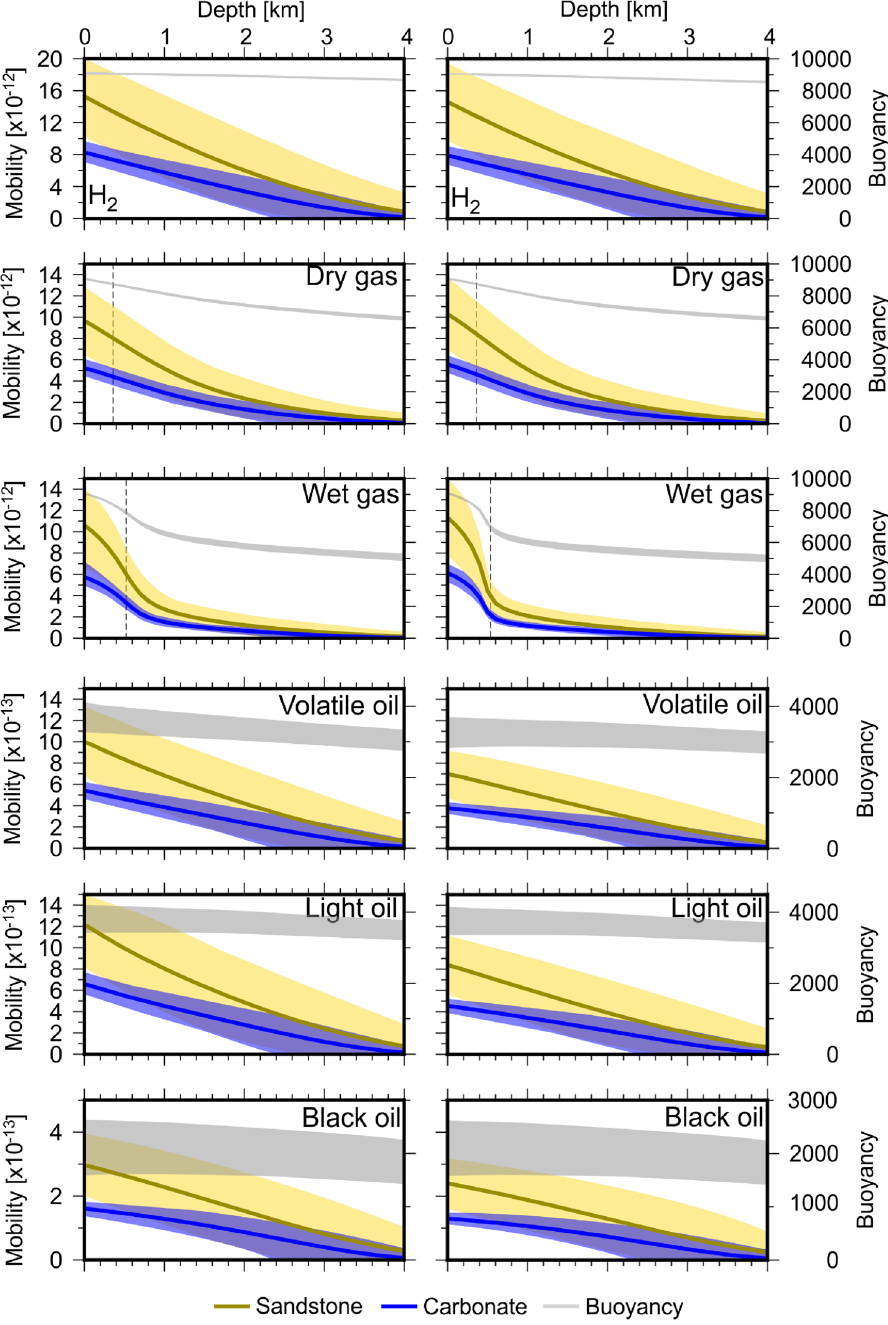
Figure 3. Fluid mobility for non-hydrocarbon and hydrocarbon fluids listed in Table 1 calculated according to Eq. (1). Units for fluid mobility are m fluid mobility in sandstone and carbonate, respectively. Grey lines represent buoyancy and shaded regions represent error. Wet and dry gas exhibit similar properties to CO 2 and methane, respectively. Phase transitions for CO 2 and methane are plotted on wet and dry gas, respectively as dashed